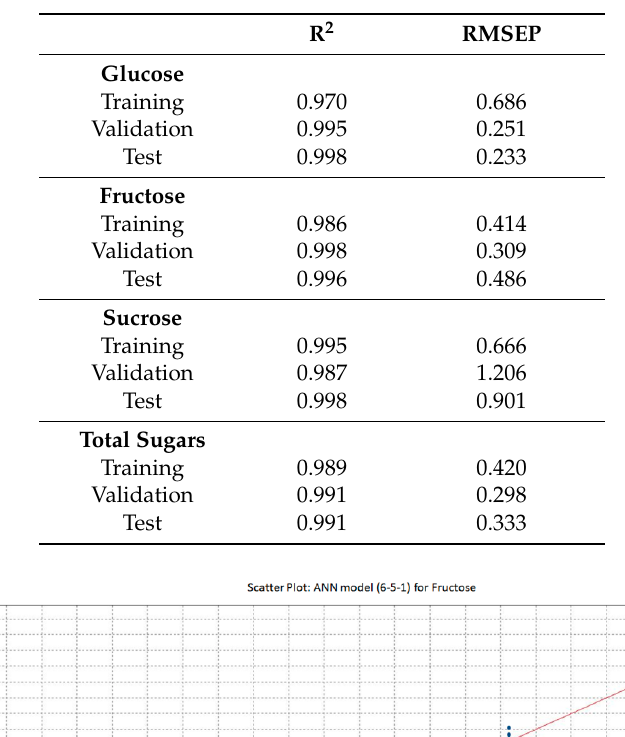
Table 3. Artificial neural network (ANN) results for the studied fermentable sugars for EIS phase data from 6.6 ˆ 10 5 Hz–7.0 ˆ 10 5 Hz (R 2 : coefficient of determination; RMSE: Root Mean Square Error).